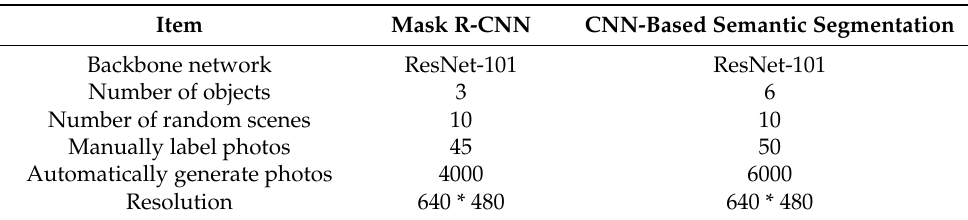
Table 1. Information of data augmentation and network training of Mask R-CNN and CNN-based semantic